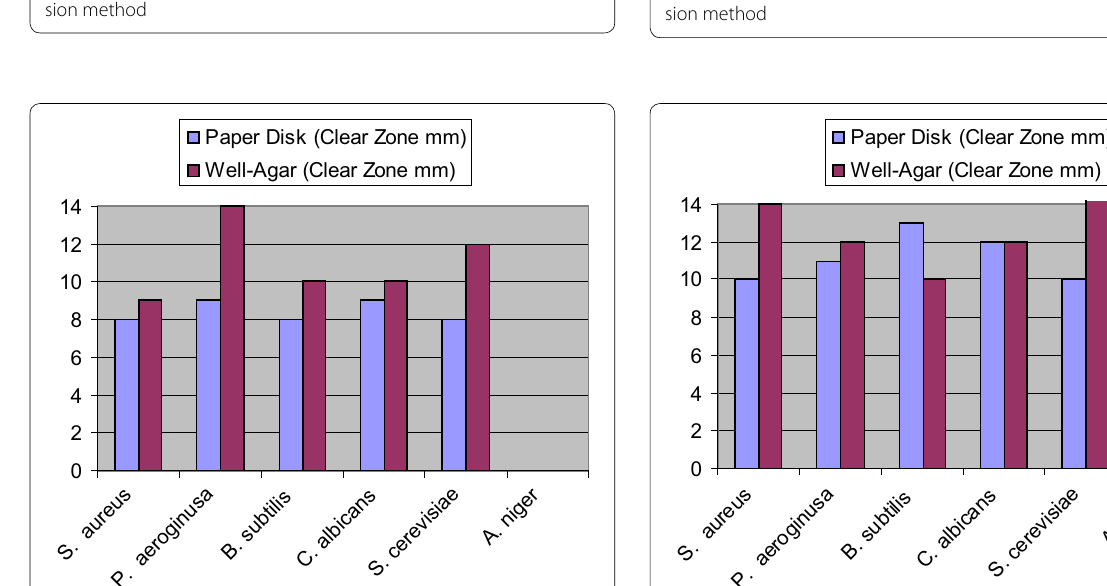
Fig. 3 Antimicrobial activity of compound 6a using agar disk diffu‑